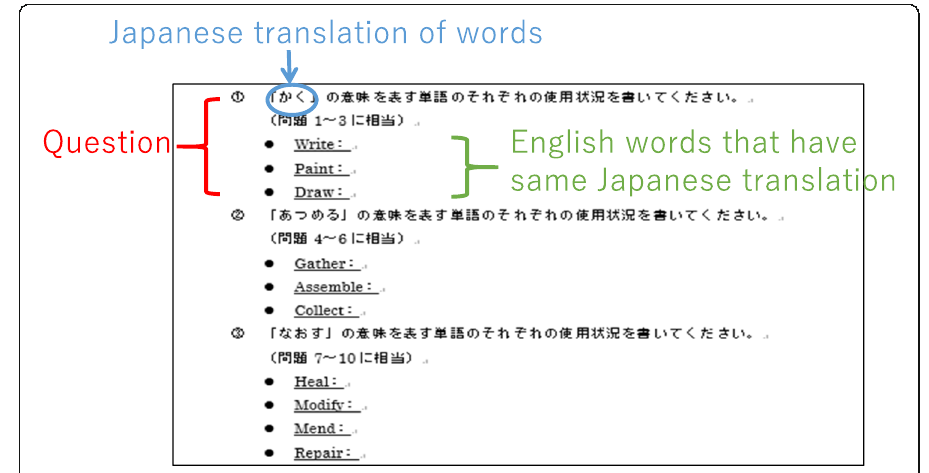
Fig. 8 Usage description in pre-test